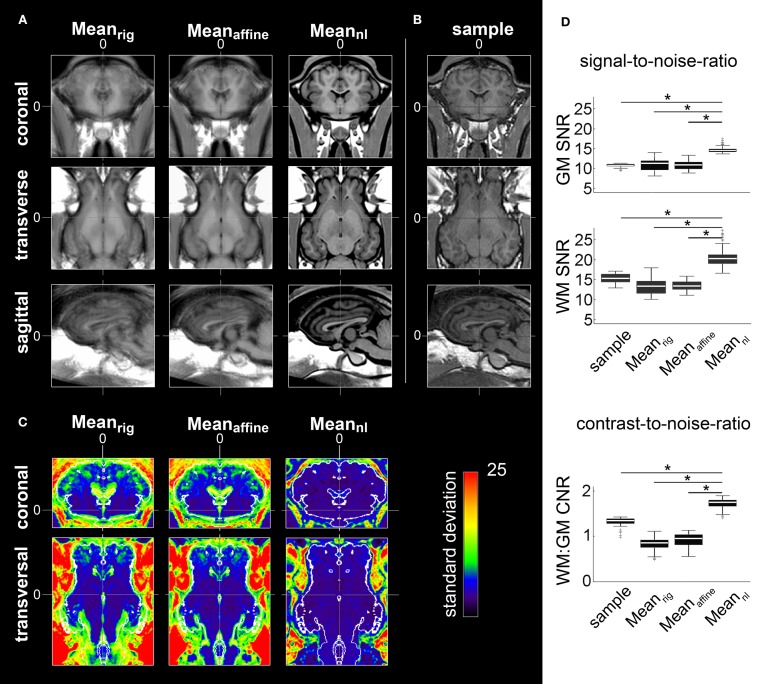
Averages after rigid body (Meanrig), affine coregistering (Meanaffine), and the final non-linear transformed template (Meannl). (A) All images have an isotropic voxel size of 0.25 mm and were registered according to ovine stereotactic space for visual comparison of the respective procedure's results. The high degree of aligment within the Meannl led to an improved boundary delineation and enhanced detail resolution. (B) Coronal, transverse, and sagittal planes of an individual brain MRI sample for comparison. (C) Coronal and transverse planes showing standard deviation of Meanrig, Meanaffine, and Meannl. The standard deviation inside the cranial cavity decreased after affine and non-linear registration. A restricted RGB lookup table was applied for better visualization of the values for each voxel inside the brain cavity. Additionally, the contour (white) of the segmented brain tissue of the template was overlaid. Stereotaxic coordinates are given in mm. (D) Comparison of SNR and CNR: compared to Meanrig, Meanaffine, and the sample GM and WM SNRs of Meannl were significantly increased. Furthermore, the CNR significantly increased in Meannl after Meanrig and Meanaffine transformation. The comparison between the sample data and Meannl revealed a significantly increased CNR in the non-linear transformed population-averaged brain template (*p < 0.05. “+” depict outliers). The box plots show 95% confidence interval, 25/75% quartile and median. GM, gray matter; WM, white matter; CSF, cerebrospinal fluid; SNR, signal-to-noise-ratio; CNR, contrast-to-noise-ratio.